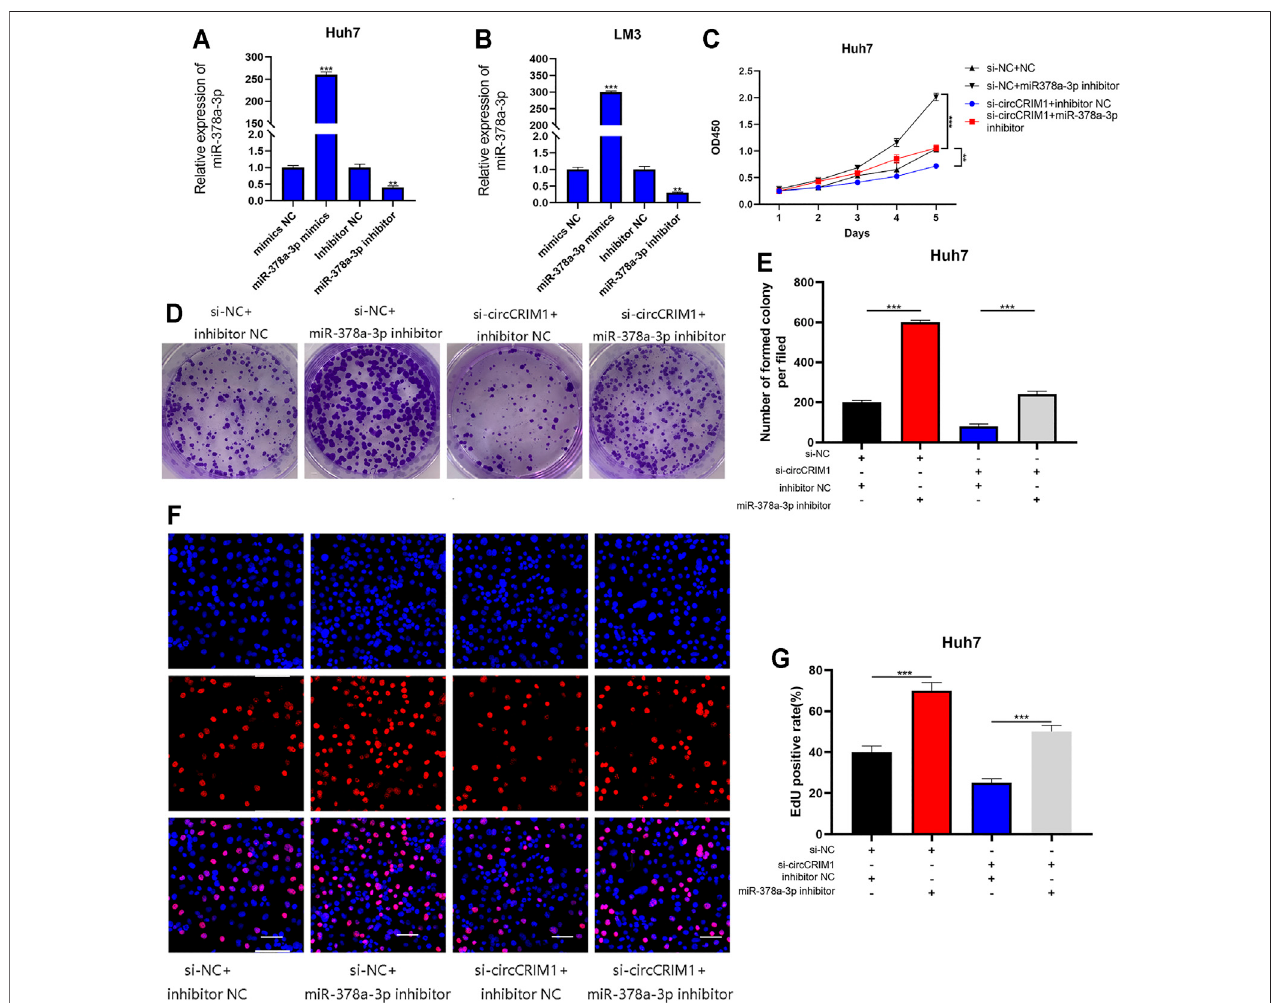
FIGURE 5 | MiR-378a-3p attenuates the oncogenic effects of circCRIM1 in HCC cells. (A,B) Expression of miR-378a-3p in LM3 and Huh7 cells transfected with miR-378a-3p mimics, inhibitor, and corresponding NC was detected by qRT-PCR. (C) Cellular growth curves were evaluated by CCK-8 assays after transfection with miR-378a-3pinhibitorandNCinHuh7cells. (D,E) Colonyformationassayswereperformedtoevaluatecellproliferation. (F,G) EdUassaysforHCCcellswereperformed toevaluatecellproliferation.Scalebar,50 μ m.Alldataarepresentedasthemeans ± SDofthreeindependentexperiments. * p < 0.05,** p < 0.01,*** p < 0.001,and **** p <